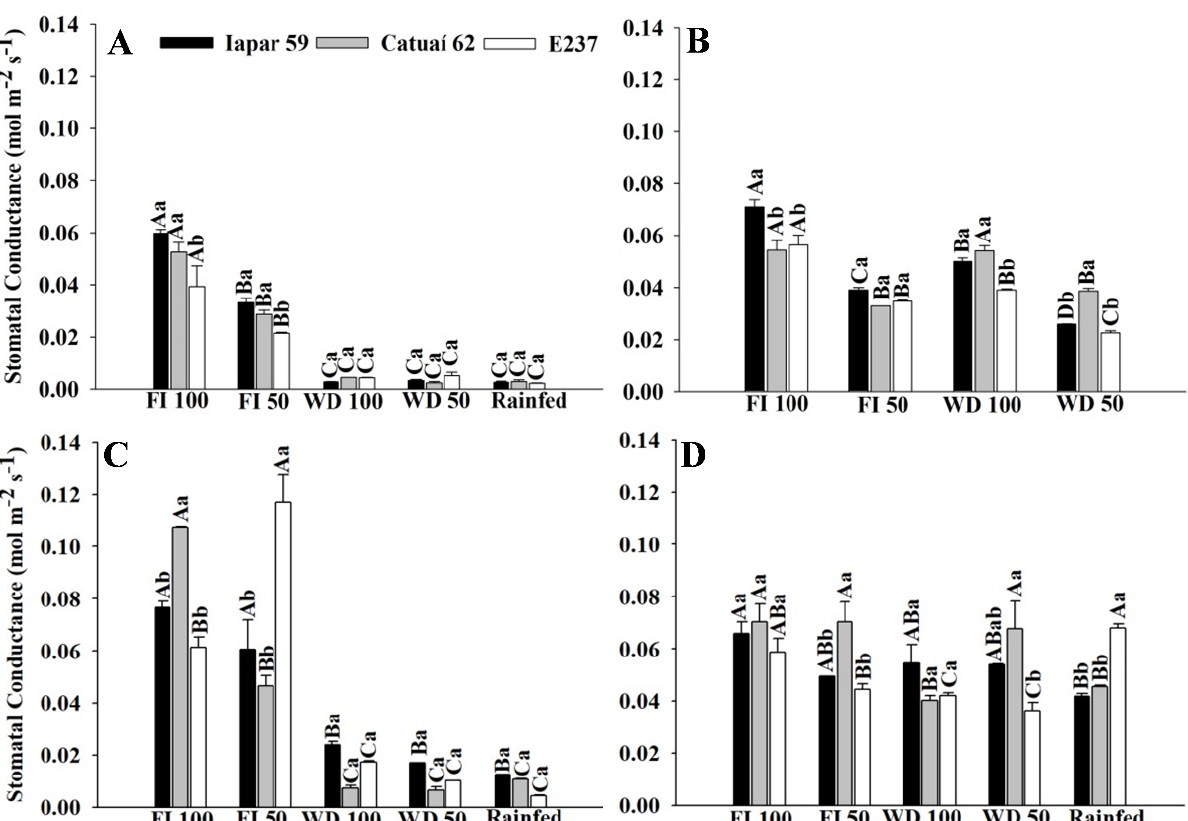
Figure 4. Stomatal conductance of coffee leaves under water stress ( A , C ) and after irrigation ( B , D ), in 2019 ( A , B ) and 2020 ( C , D ), of three arabica coffee genotypes (Iapar 59, Catuaí 62 and E237) under five water regimes (FI 100, FI 50, WD 100 WD 50 and rainfed). Capital letters compare the water regimes for each cultivar and lowercase letters compare the cultivars of each water regime. Means followed by the same letter do not differ according to the Tukey test at 5% probability. FI 100 and 50 (full irrigation with 100% and 50% replacement of evapotranspiration); WD 100 and 50 (water deficit with the suspension of irrigation from June to September, with replacement of 100% and 50% of evapotranspiration, respectively); rainfed (without irrigation). Table 1. Relative water content (RWC) in leaves of three coffee arabica genotypes (E237, Iapar 59